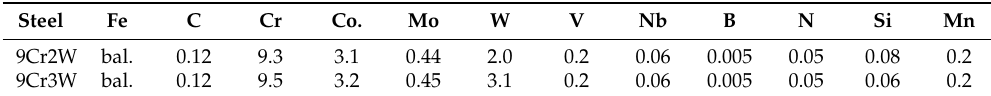
Table 1. Chemical composition of the steels studied (wt